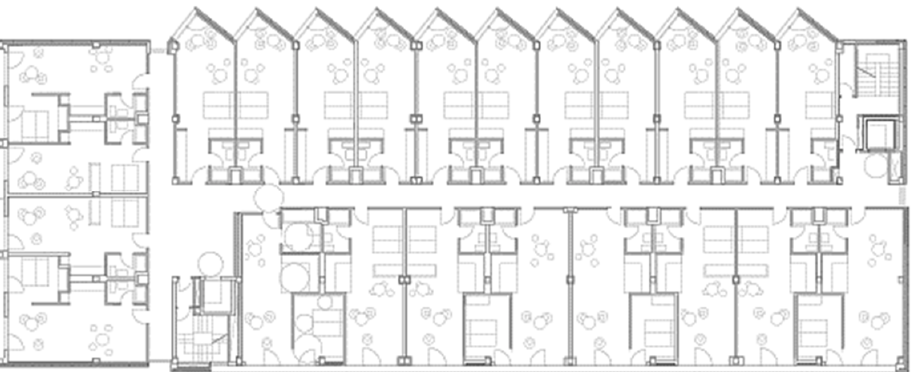
Figure 2. General floor plan of the project for 107 housing units in Txurdinaga by Oneka Arquitectura studio. Source: authors.